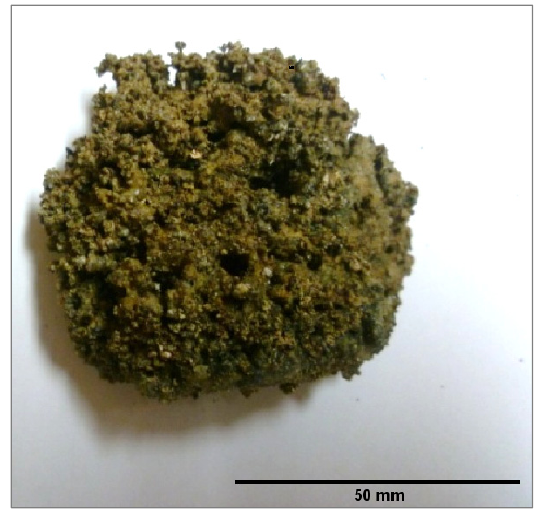
Figure 3. Bed sintering of wood pellet after 3 h of stable